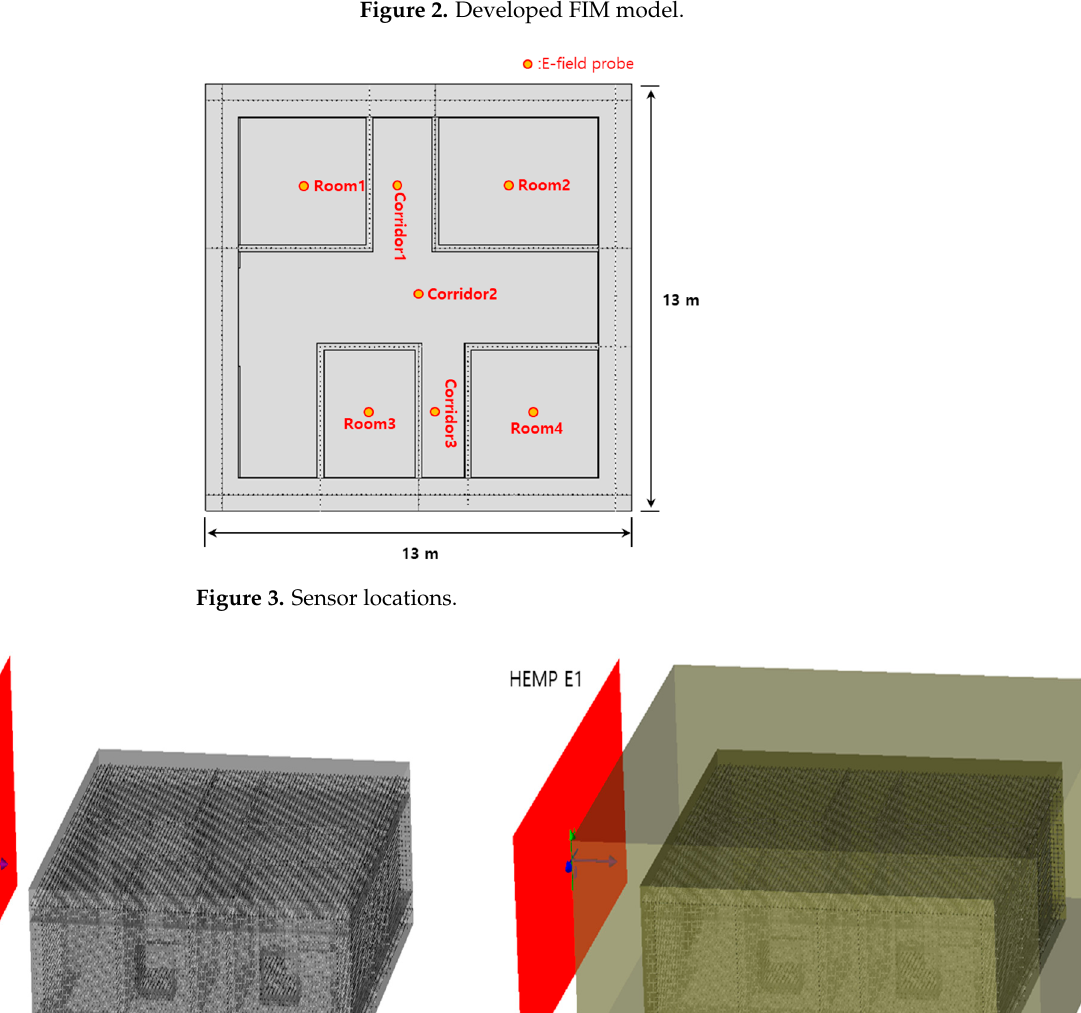
Figure 2. Developed FIM model.